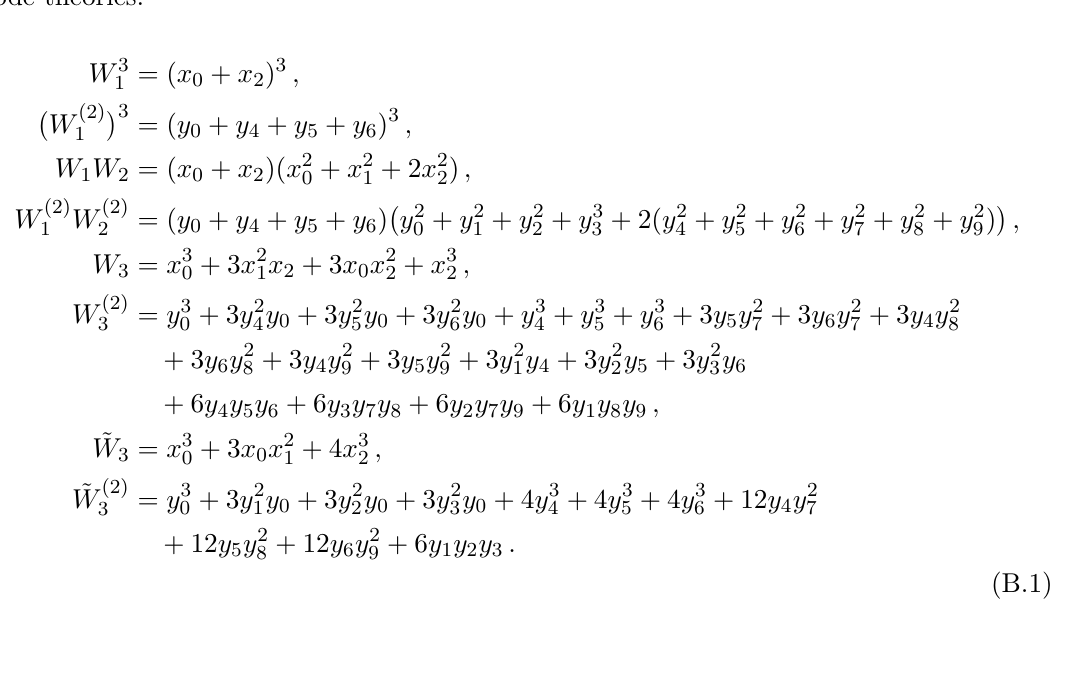
Figure 11. Graph representation of Q [2]